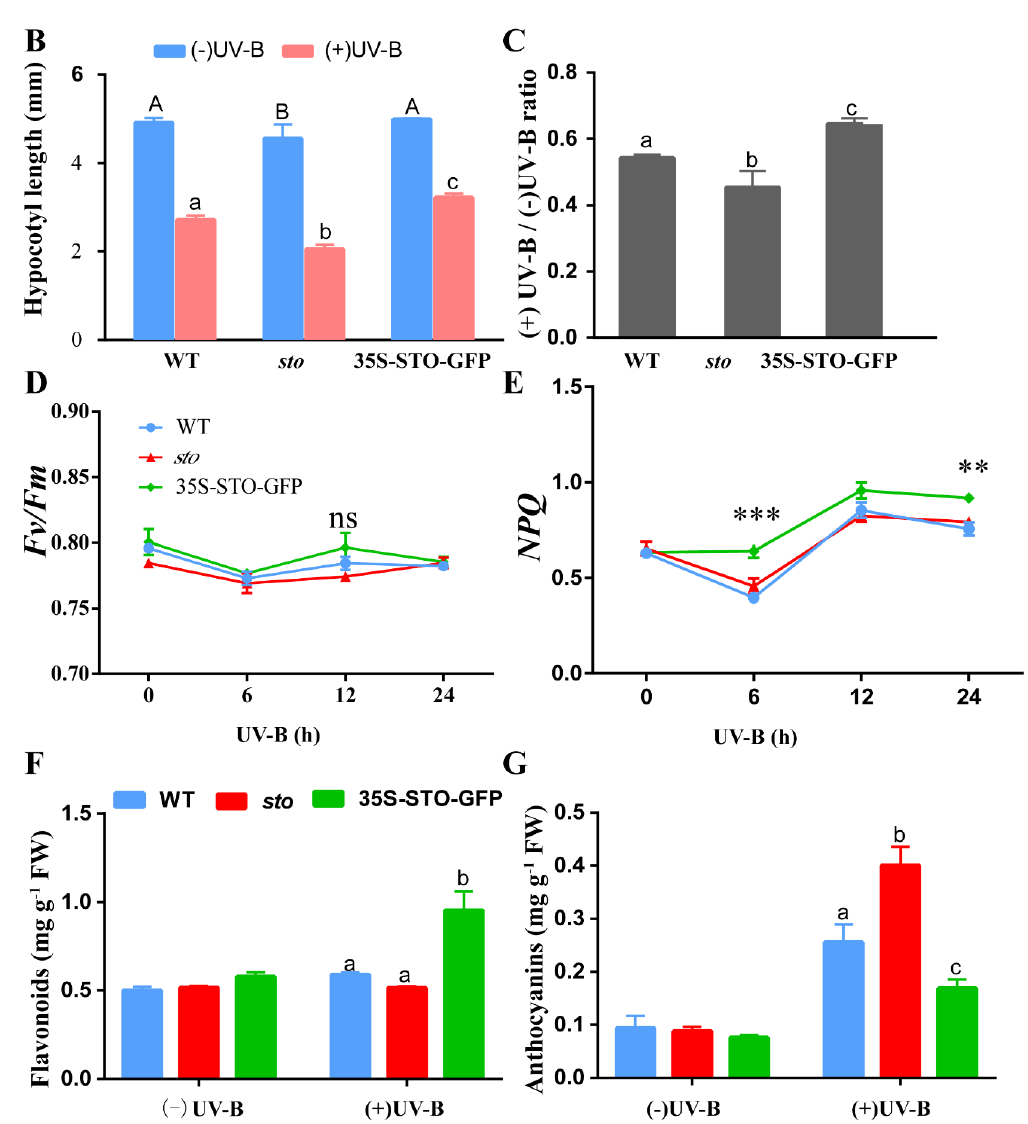
Figure 10. Physiological responses of STO under UV-B radiation. ( A ) Images of the six-day-old sto , WT, and 35S-STO-GFP seedlings with or without UV-B radiation. UV-B radiation was 0.6 W / m 2 ; scale bar = 1 mm. ( B ) Hypocotyl length of the sto , WT, and 35S-STO-GFP seedlings with or without UV-B radiation. Data are expressed as means ± standard deviation (SD); n > 30. The upper- and lower-case letters indicate the results of the Dunnett’s multiple comparisons test on the di ff erence in hypocotyl length between those seedlings without or with UV-B exposure, respectively ( P < 0.05). ( C ) The grey bars show the ratio of hypocotyl length with or without UV-B radiation ( + UV-B / -UV-B). Data are shown as means ± SD ( n > 30). Di ff erent letters indicate statistically significant di ff erences ( P < 0.05, one-way ANOVA). ( D ) and ( E) Fv / Fm and NPQ of sto , WT, and 35S-STO-GFP seedlings after UV-B exposure. The seedlings were grown in white light for seven days and then exposed to UV-B (0.6 W / m 2 ). Fv / Fm and NPQ were measured using CF Imager (Technologica). Data are shown as mean ± SD ( n > 20). “*” indicates a statistically significant di ff erence, and “ns” means no significant di ff erence ( P < 0.05, Dunnett’s multiple comparisons test). ( F ) and ( G ) Anthocyanin and flavonoid contents in the seedlings with or without UV-B radiation. The seedlings were grown in the soil under white light for 12 d and then subjected to a three-day UV-B (0.6 W / m 2 ) exposure. The seedlings were then measured for anthocyanin and flavonoid contents. Data are shown as means ± SEM ( n = 6). Di ff erent letters indicate significant di ff erence ( P < 0.05, Dunnett’s multiple comparisons